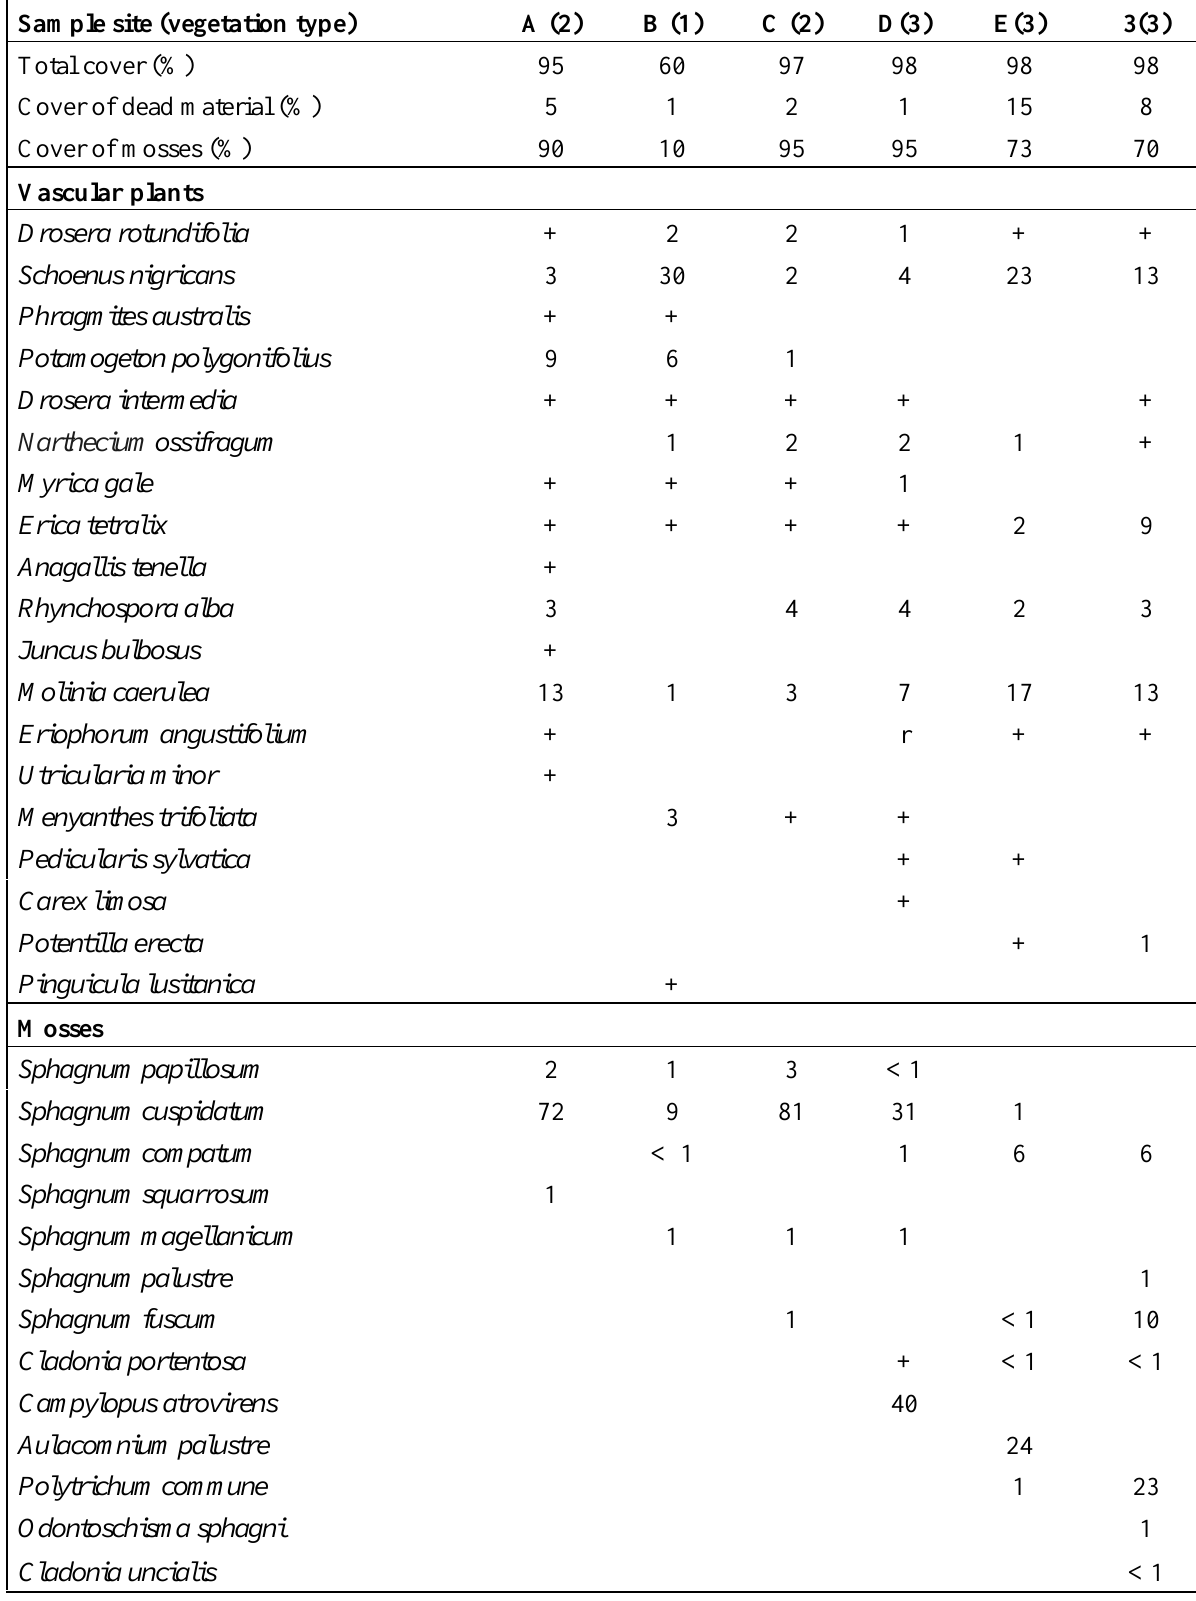
Table A1. Vegetation relevés on some sample points (June 2012). Sample site (vegetation